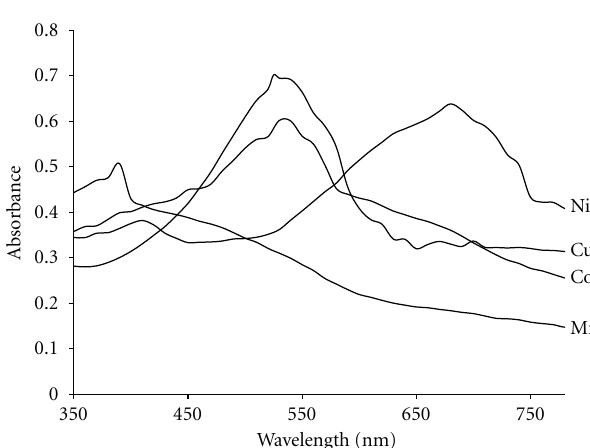
F 2: Electronic spectra of OCMC Metallic Gel complexes.